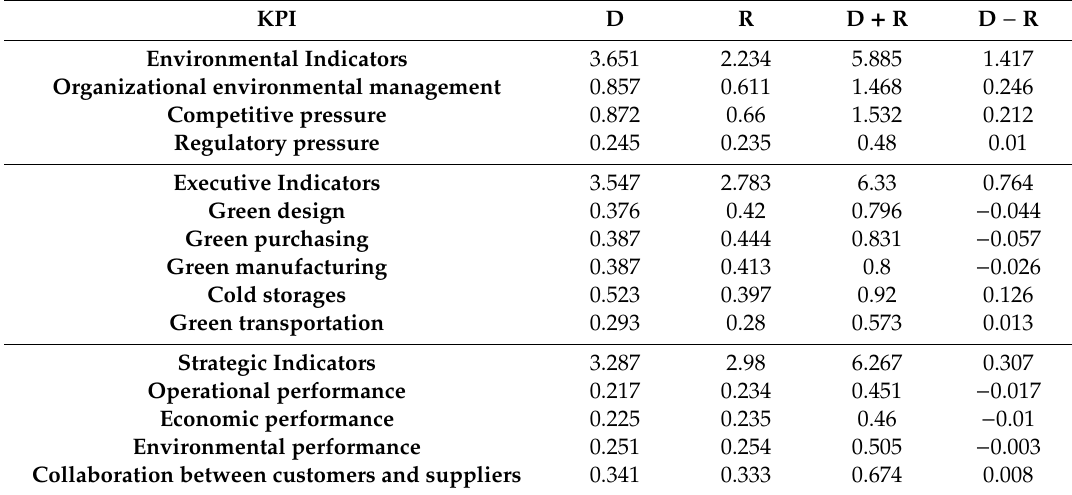
Table 8. Results of the calculations of the e ff ect of performance indicators